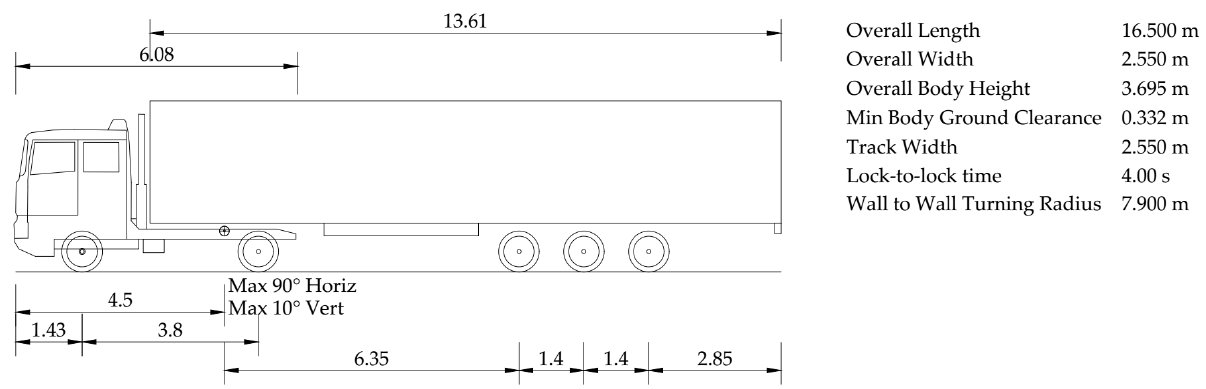
Figure 4. Design vehicle truck with a semi-trailer.